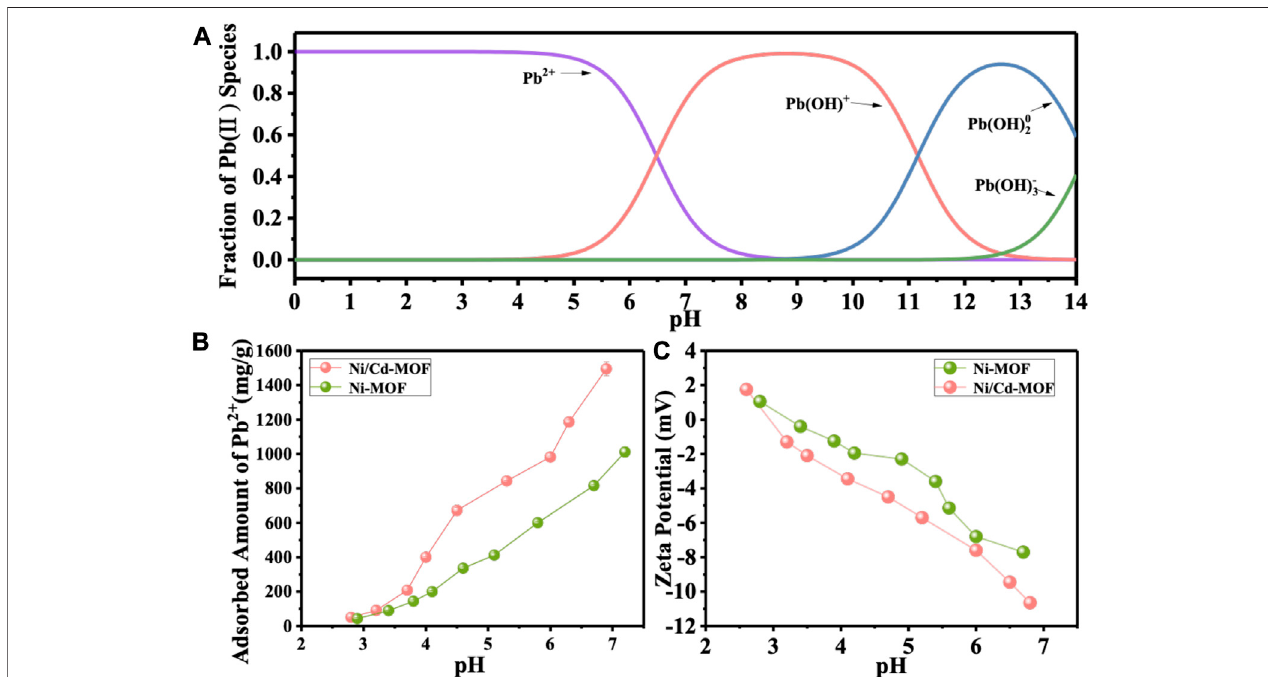
FIGURE 6 | (A) Fraction of Pb(II) species at different pH solution; (B) adsorption of Pb 2+ by Ni-MOF and Ni/Cd-MOF at different pH. (C) Zeta potential of Ni-MOF and Ni/Cd-MOF at different